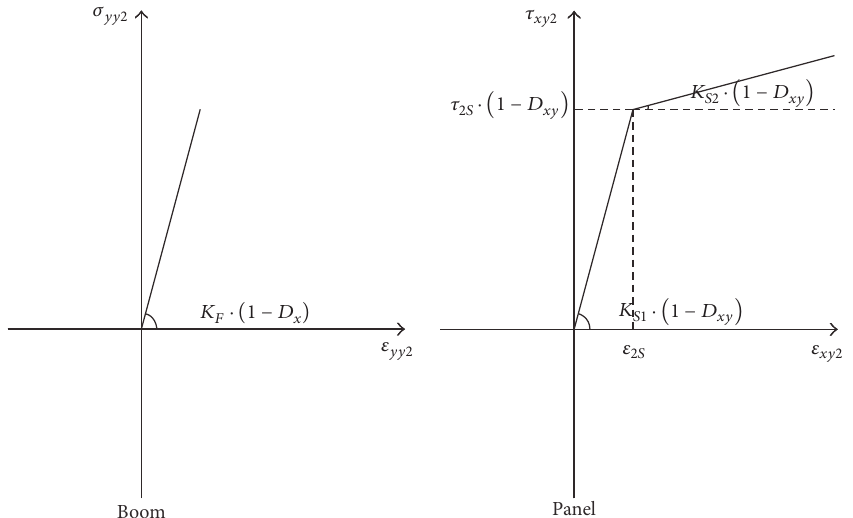
Figure 5: The constitutive law with damage for boom-panel